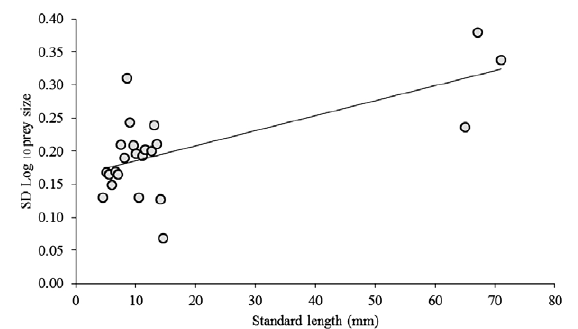
Fig. 7. – Trophic niche breadth variation of S. sanguineus during early ontogenetic